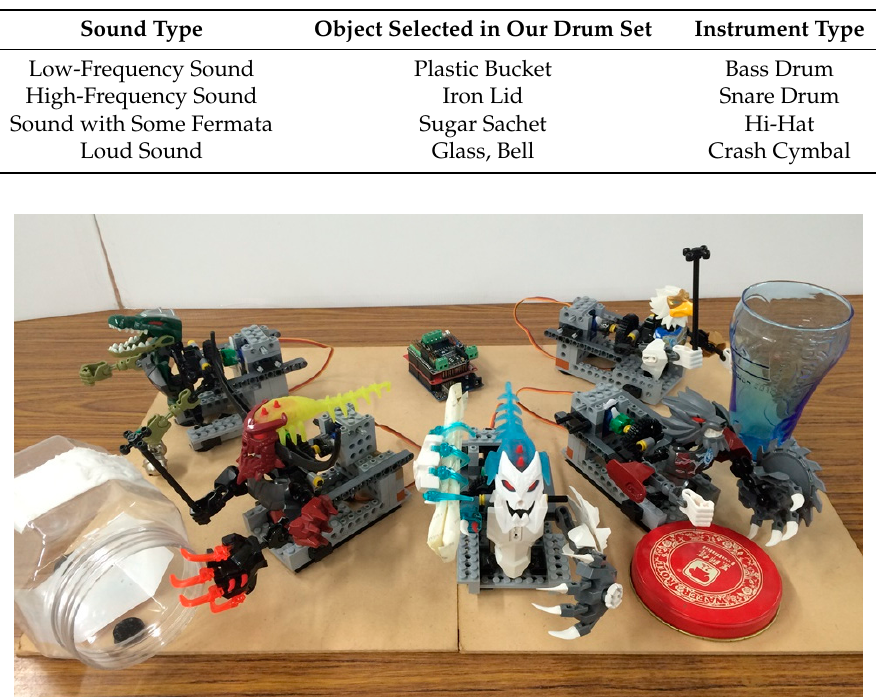
Figure 7. Interactive robot performance system.